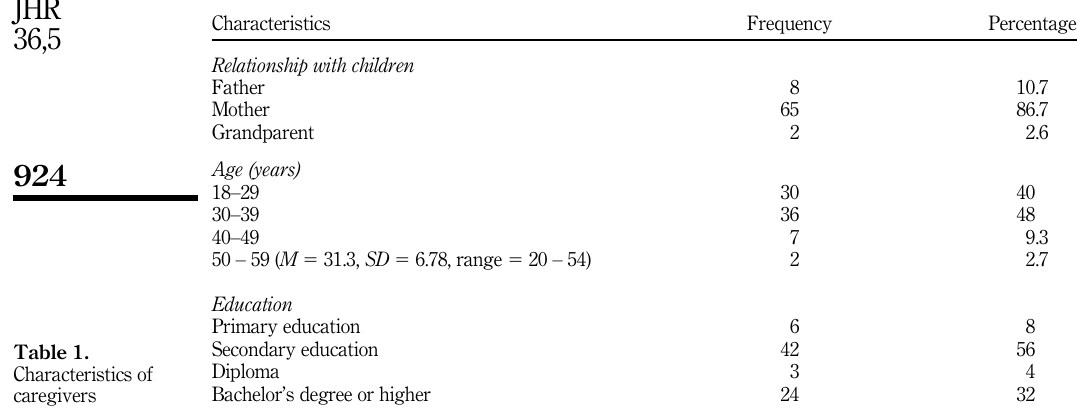
Table 1. Characteristics